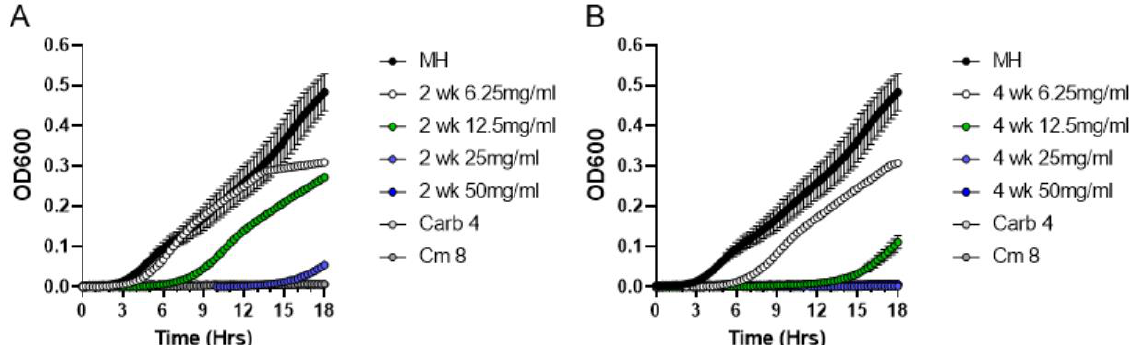
Figure 4. Broth microdilution method to determine minimum inhibitory concentration (MIC) of metabolites present in P. patens Gd exudates . Exudates from two-week-old ( A ) or four-week-old ( B ) P. patens Gd ecotype were tested in MIC assays against S. aureus ATCC25923. Growth curve of S. aureus cells was monitored in the presence of 6.25, 12.5, 25 and 50mg/mL of exudate solution. MH —negative control, no exudate added. Carbenicillin (Carb, 4 μg /mL) and chloramphenicol (Cm, 8 μg /mL) treatments were used as positive controls for S. aureus growth inhibition.